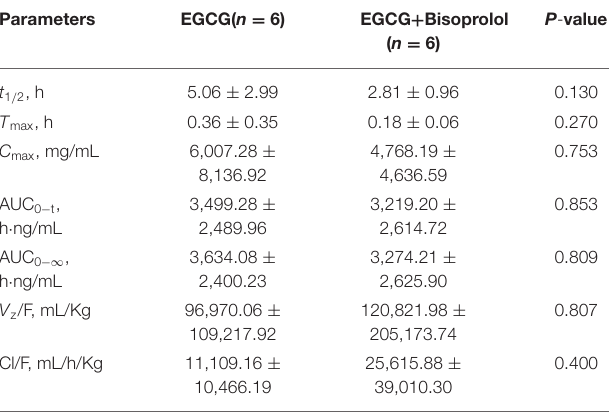
TABLE 6 | Pharmacokinetic parameters of EGCG after intragastric administration in SD rats.